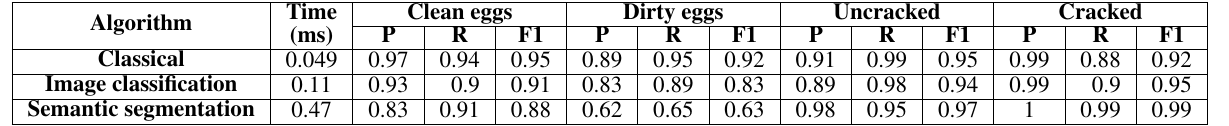
Table 3. Comparison of the results obtained by the proposed algorithms for egg